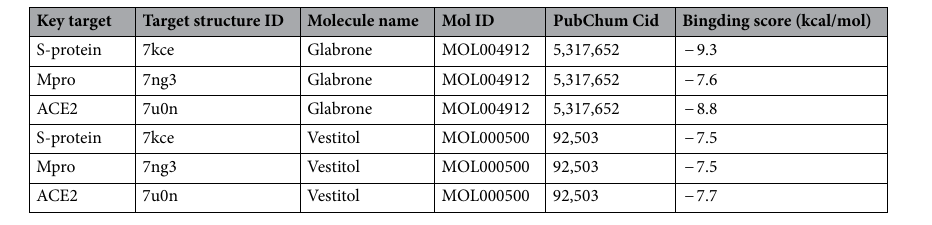
Table 8. Molecular docking results for glabrone and vestitol.